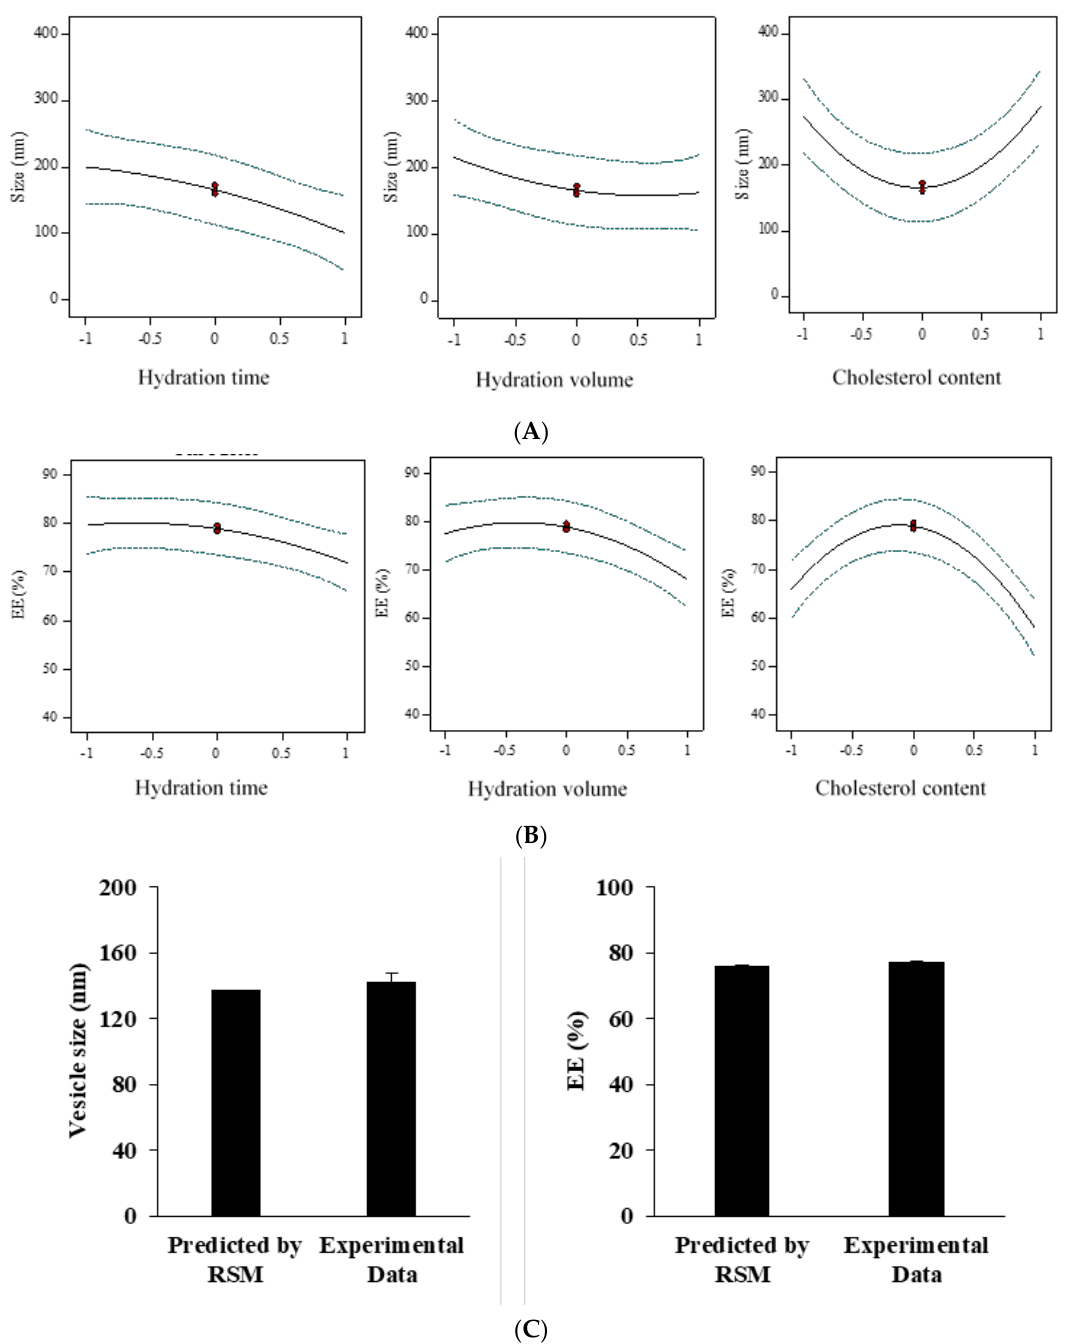
Figure 1. Box-Behnken method for average diameter ( A ) and encapsulation efficiency (EE) ( B ) as a function of the cholesterol content, hydration time, and hydration volume. The optimized responses thereof were in line with the experimental data ( C ), N = 3.